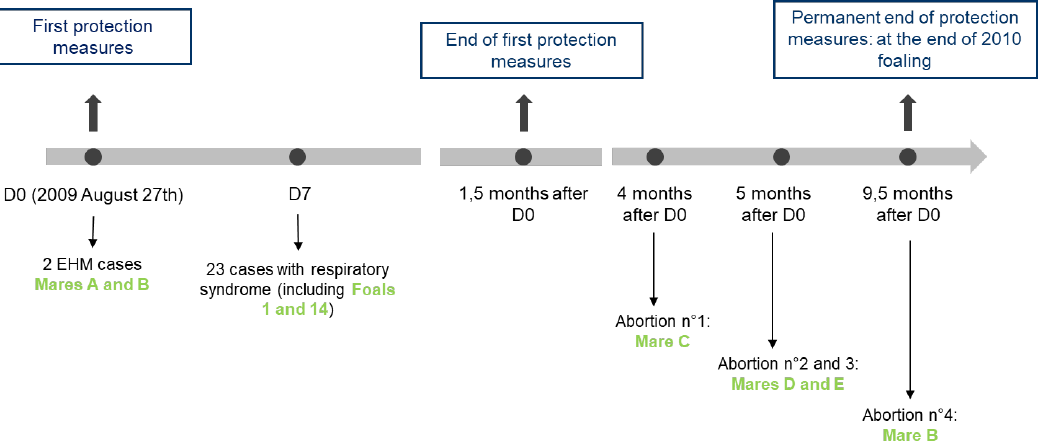
Figure 1. The 2009 EHV-1 outbreak chronology from D0 = day of the first case declaration, to 9.5 months after D0. D7 = Day 7 after the first case was declared. The biosecurity measures that were taken during this outbreak are described in blue boxes. Table 2. Group composition for mares and foals on the French stud farm.